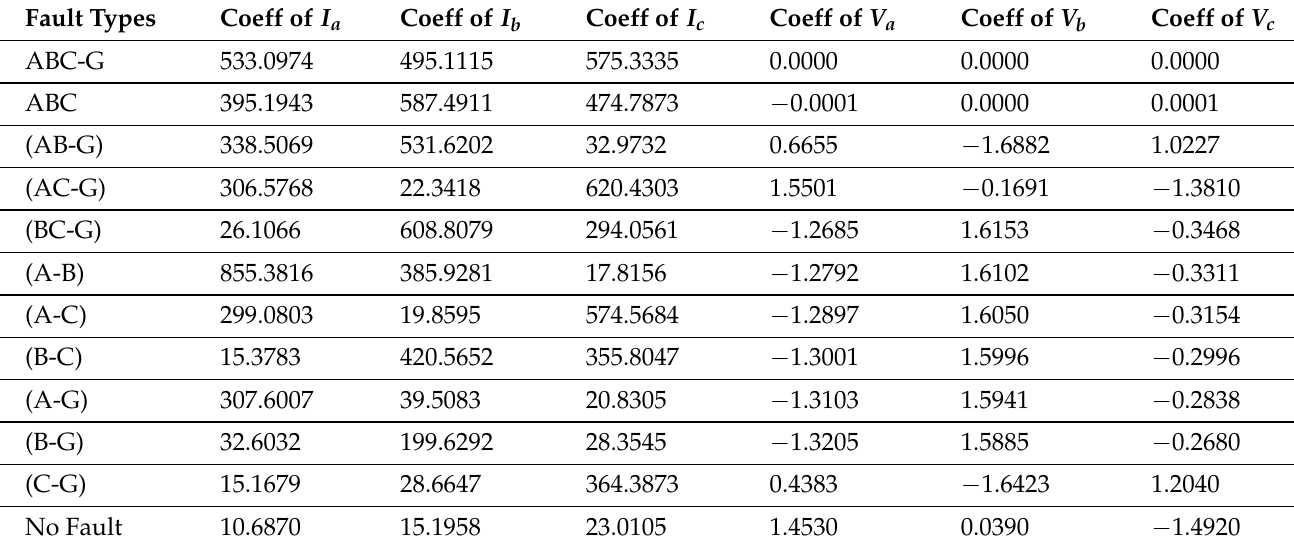
Table 1. Faulty current and voltage data in kA and kV.